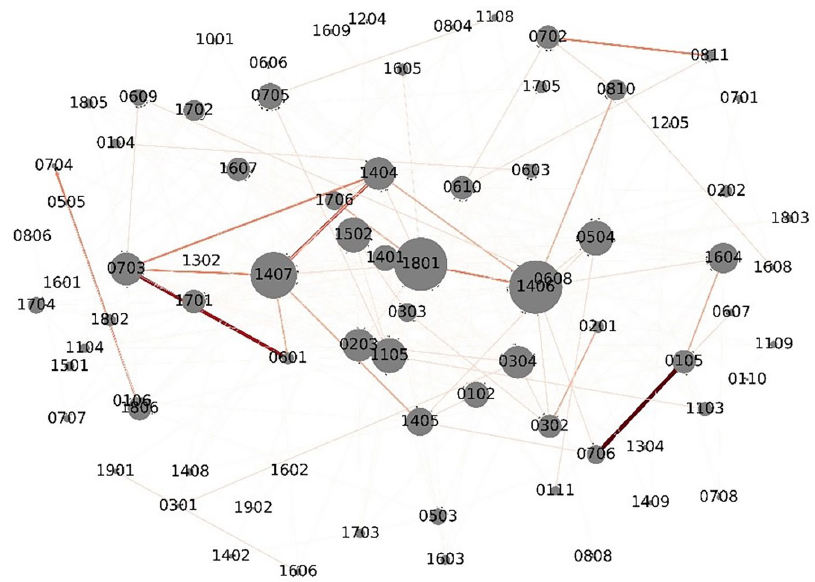
Figure 4. Establishment of the model of